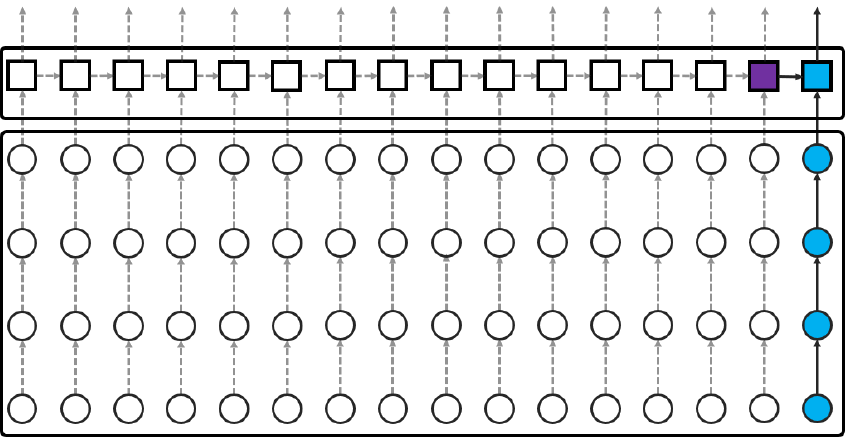
Figure 10. Learning process of single frame + LRCN (Note: Purple denotes data in the past and currently needed, blue denotes the number of nodes needed in current